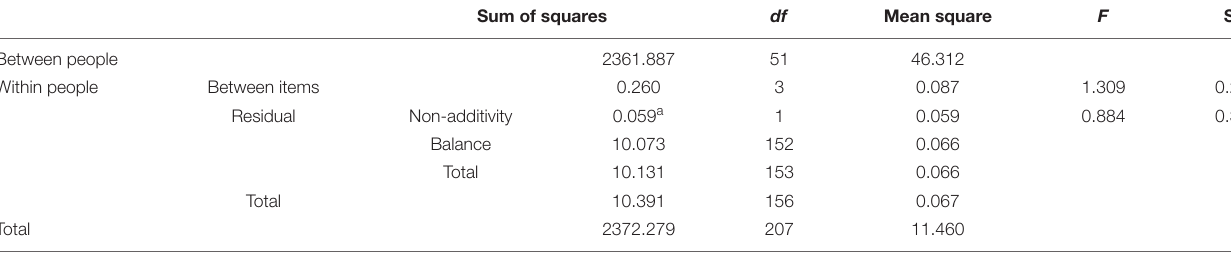
TABLE 5B | ANOVA with Tukey’s test for non-additivity.